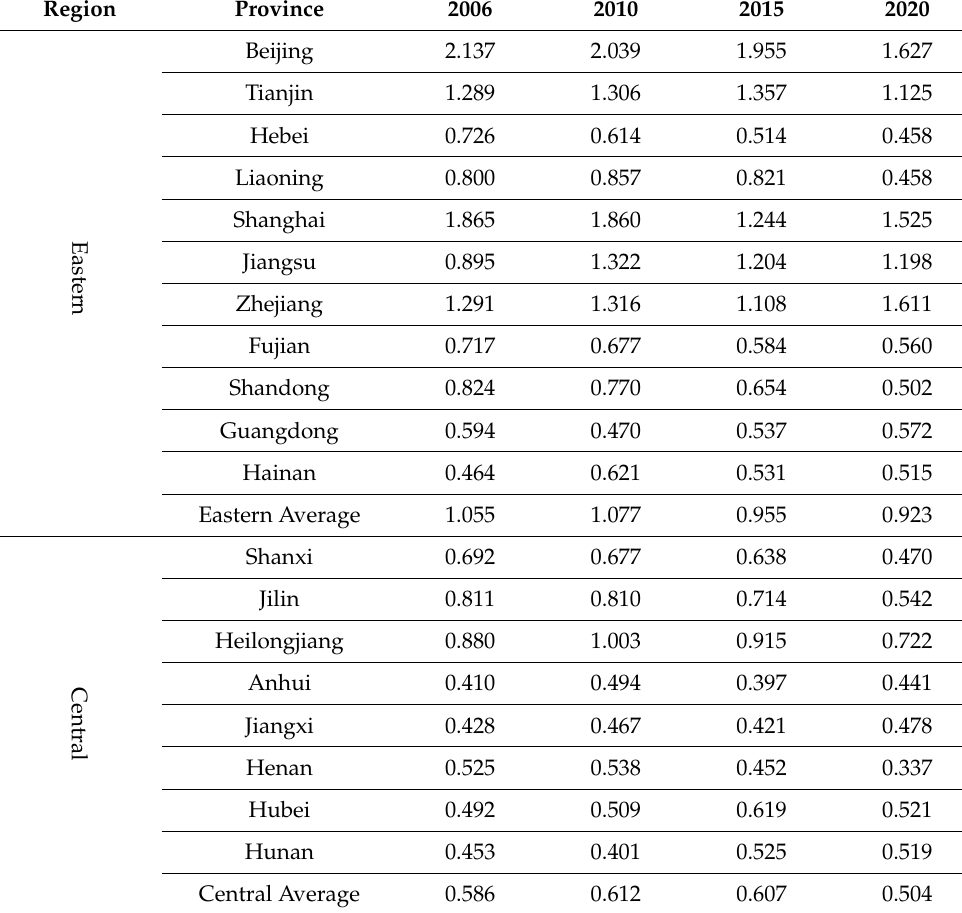
Table 3. Livelihood resilience of rural residents in China by province.